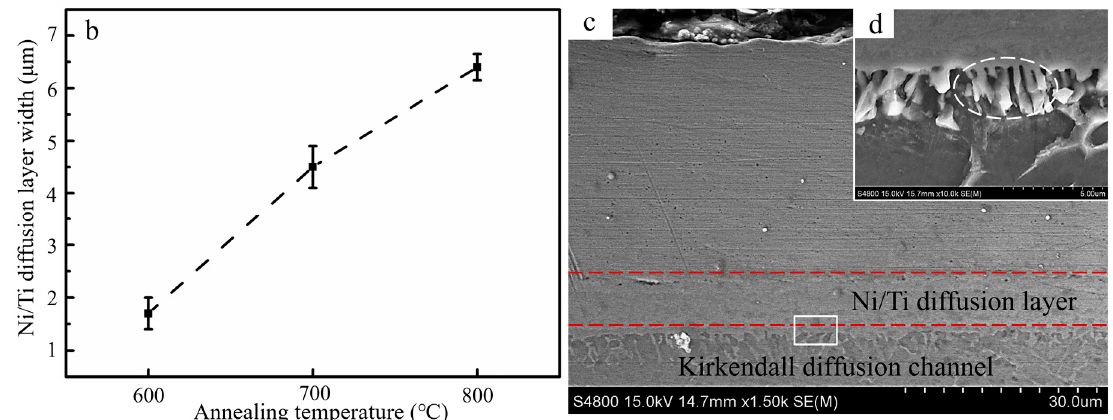
Figure 2. Microstructure of the Ni/Cu/Ni coatings after annealing at various temperatures: ( a ) cross section and corresponding element composition, ( b ) Ni/Ti diffusion layer width, and ( c ) the diffusion layer structure SEM of the Ni/Ti interface for 800 °C. The obvious Ni/Ti diffusion layers were observed in the red line. ( d ) showed the Kirkendall diffusion channel, which was shown in the white area.